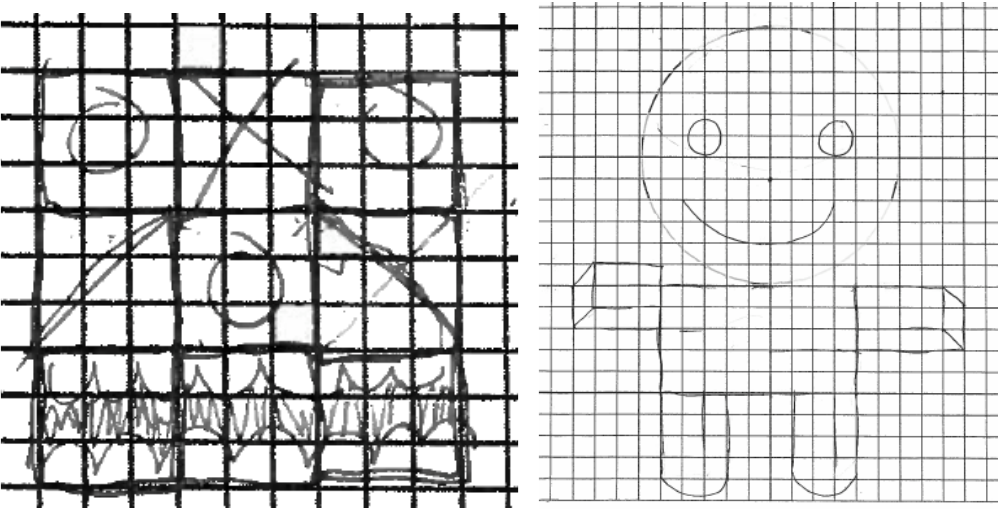
Figure 4. Group 3’s created